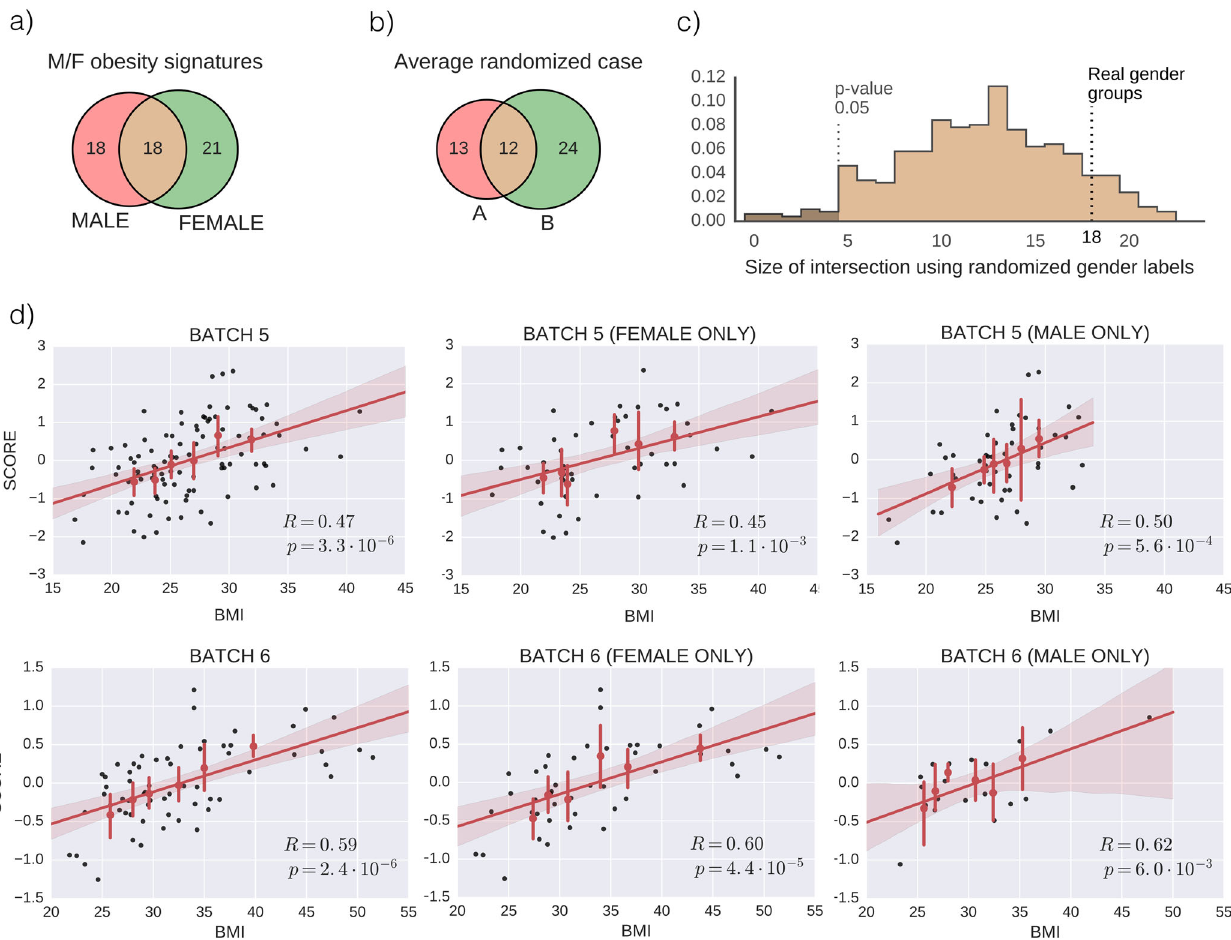
Fig. 3 The obesity signature is not gender-dependent a Venn diagram of male/female signatures. b Venn diagram of a representative example of random A/B signatures, showing that the overlap obtained with male/female groups is qualitatively similar to that obtained with random A/B groups of the same sizes (see Methods Section in main text for details). c Null distribution of number of overlapped genes, showing that the overlap of 18 genes in the real male/female signature is compatible ( p = 0.874) with the null hypothesis of gender- independent signature. d Scatter plots for batches 5 and 6, using all samples ( left column ), female-patient samples only ( middle column ) or male-patient samples only ( right column ). The fi gure shows that the association between the obesity score and BMI is statistically signi fi cant in both male-only and female-only populations (notice that the reported p -values in the male-only and female-only panels are lower than their all-gender counterparts, but this is due to the decreased number of